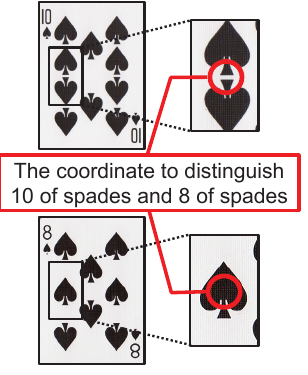
Figure 10. The reason the system mistook the 10 of Spades as the 8 of Spades.